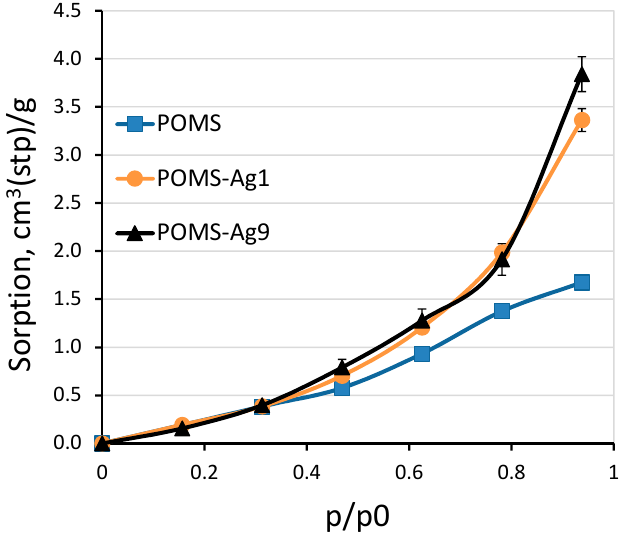
Figure 8. Water vapor isotherms in POMS (square), POMS-Ag1 (circle), and POMS-Ag9 (triangle) at 35 °C.